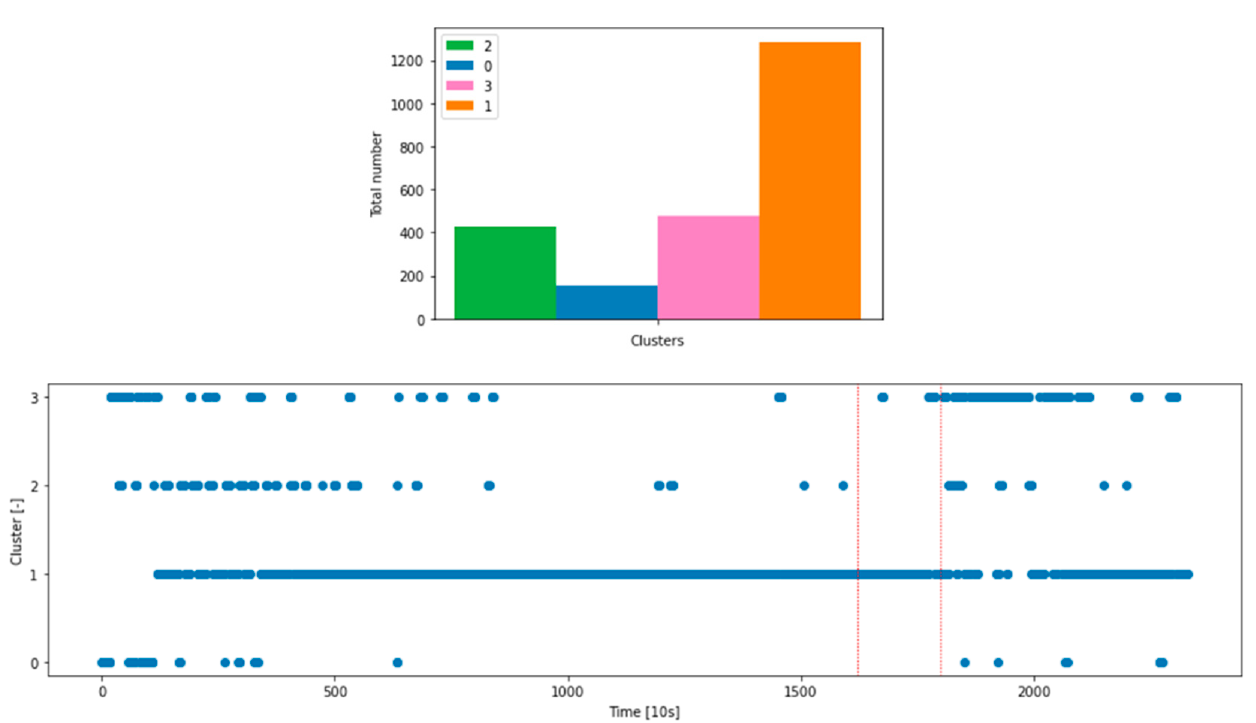
Figure 8. Size of clusters and temporal evolution of cluster predictions using the K-means algorithm.